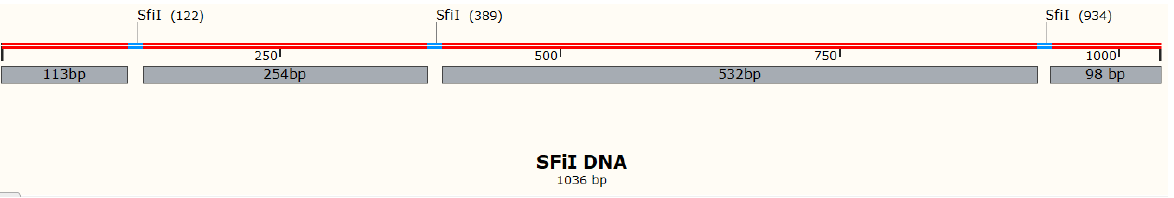
Figure 1. Schematic of the DNA construct with three SfiI recognition sites. The SfiI sites are represented as blue horizontal bars. Numbers below the red bar indicate base pair distance from the